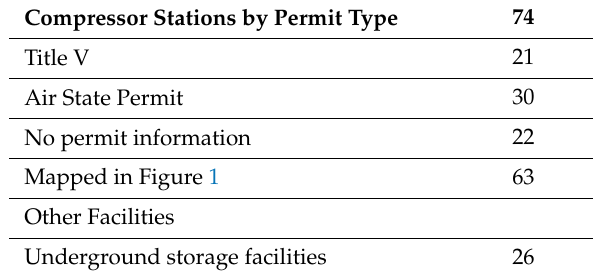
Table 1. New York State (NYS) compressor stations and related facilities.